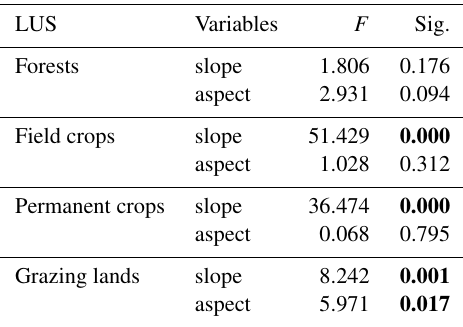
Table 5. MANOVA results regarding significance of all the vari- ables under different